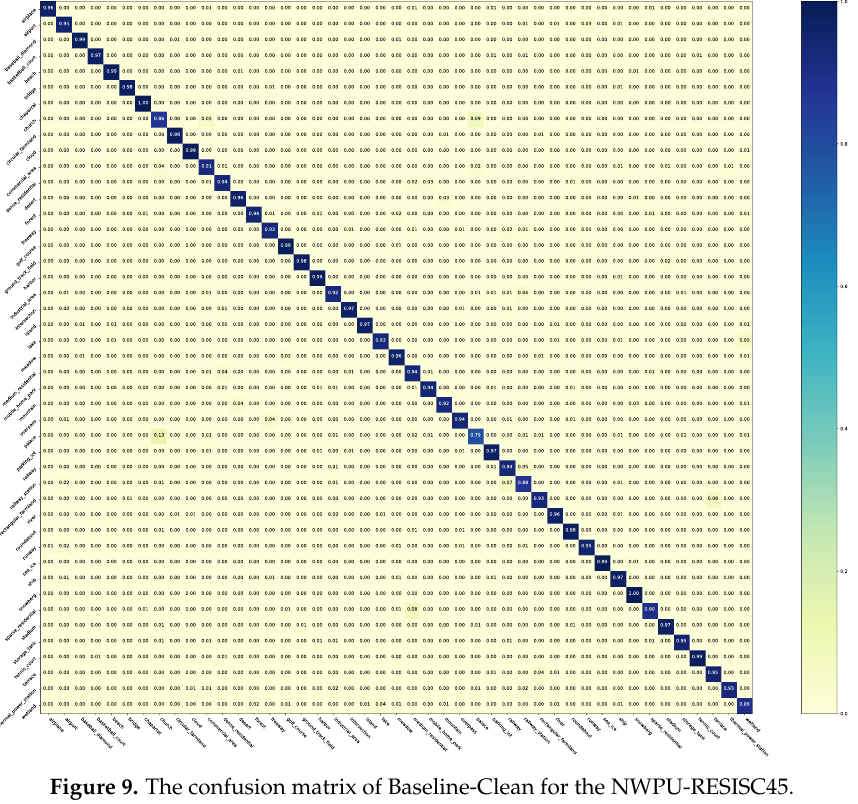
Figure 9. The confusion matrix of Baseline-Clean for the NWPU-RESISC45.